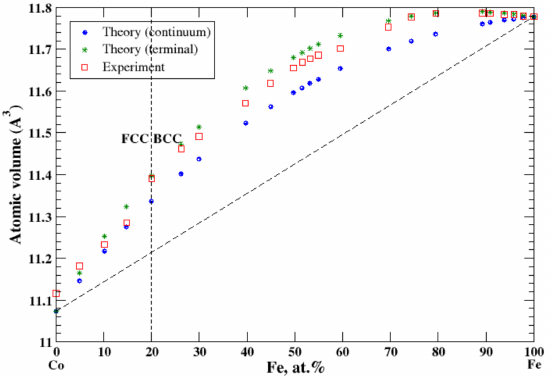
Figure 12. Atomic volume vs. concentration for Fe-Co alloy system. The experimental data are from Ref. [16] (p. 505 and p. 634).